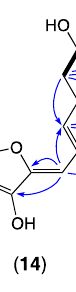
Figure 10. Isomeric substructures featuring a substituted ( a ) dihydrobenzofuran, ( b ) dihydroben- zopyran, and ( c ) epoxide. Highlight (blue) indicated key oxygenated residues.